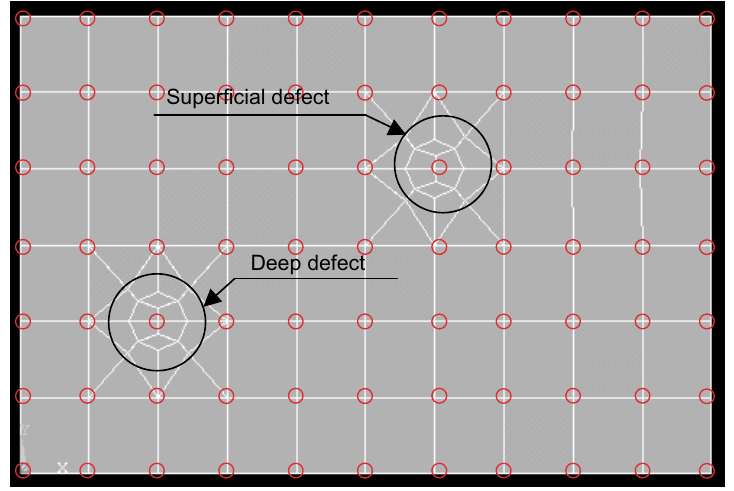
Fig. 6. Numerical model of a plate with two